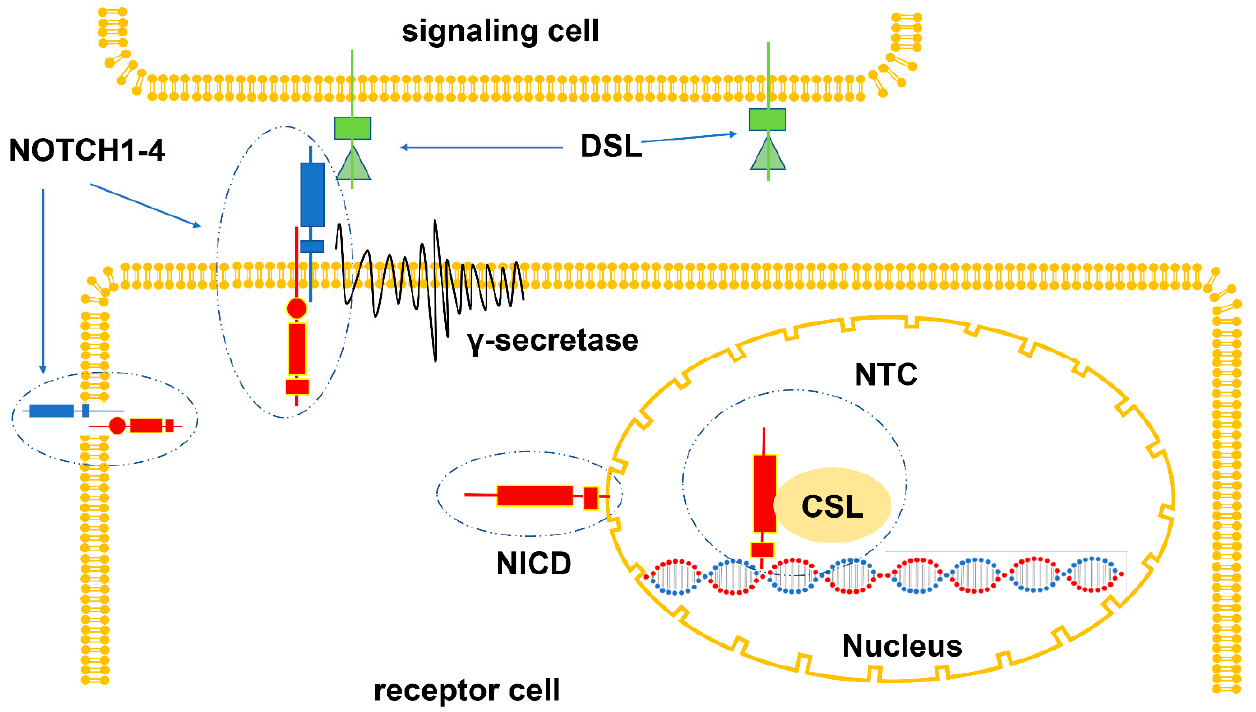
Figure 1. The Notch signaling